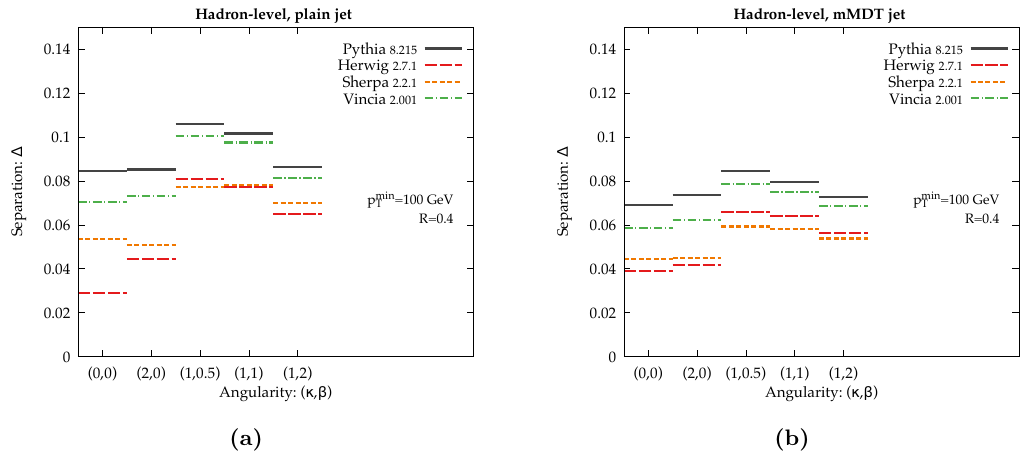
Figure 19. Classi(cid:12)er separation (cid:1) for the (cid:12)ve benchmark angularities in our LHC study, deter- mined from the various generators (a) using all jet constituents and (b) after mMDT grooming. Note that the plotted range is di(cid:11)erent from (cid:12)gure 7, re(cid:13)ecting the decreased discrimination